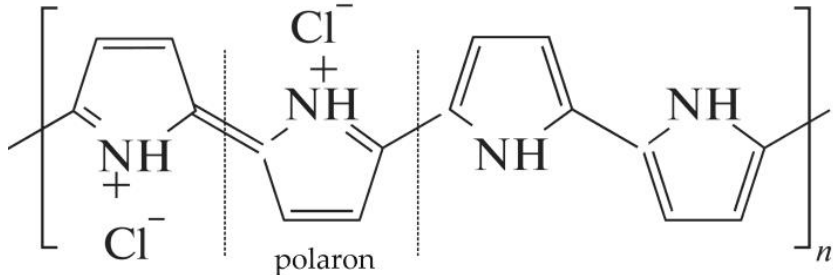
Figure 2. PPy structure.